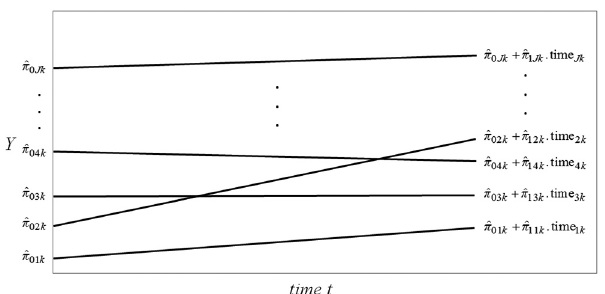
Figure A1. Individual models that represent the temporal evolution of the dependent variable for each of the J Level-2